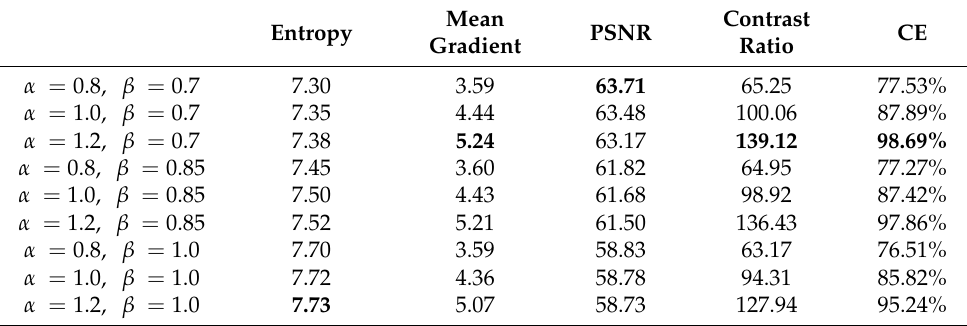
Table 2. Enhancement performance of different parameter combinations.